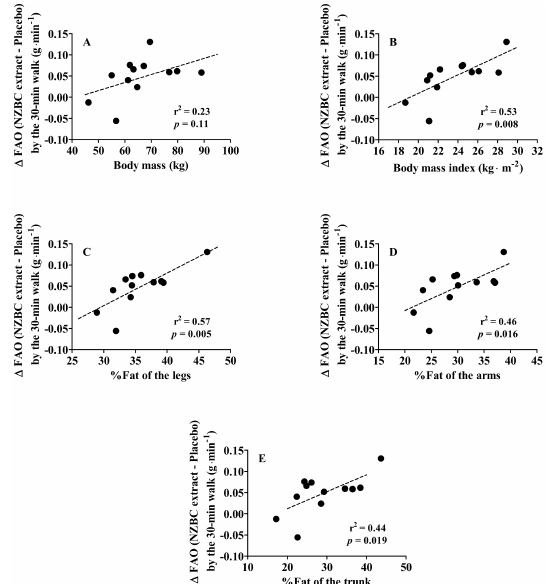
Figure 3. Relationship between body mass ( A ), body mass index ( B ), %fat of the legs ( C ), %fat of the arms ( D ), and %fat of the trunk ( E ) and the changes in fat oxidation ( ∆ FAO) by 30 min of moderate-intensity treadmill walking with intake of New Zealand blackcurrant (NZBC) extract. The ∆ FAO is the fat oxidation with intake of New Zealand blackcurrant extract minus the fat oxidation with intake of placebo. The dotted lines are the linear regression